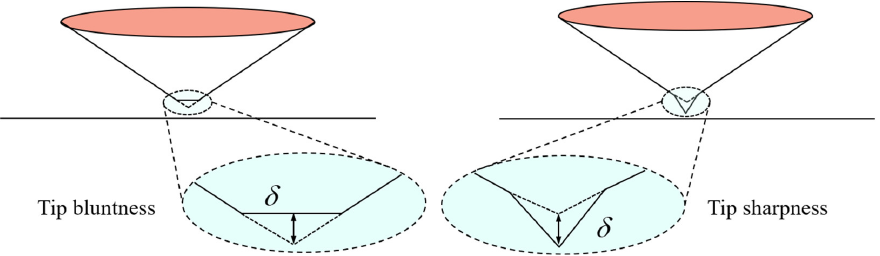
Figure 3. The indenter tip irregularity includes tip bluntness and tip sharpness. Here, represents the length scale of irregular tip shapes.